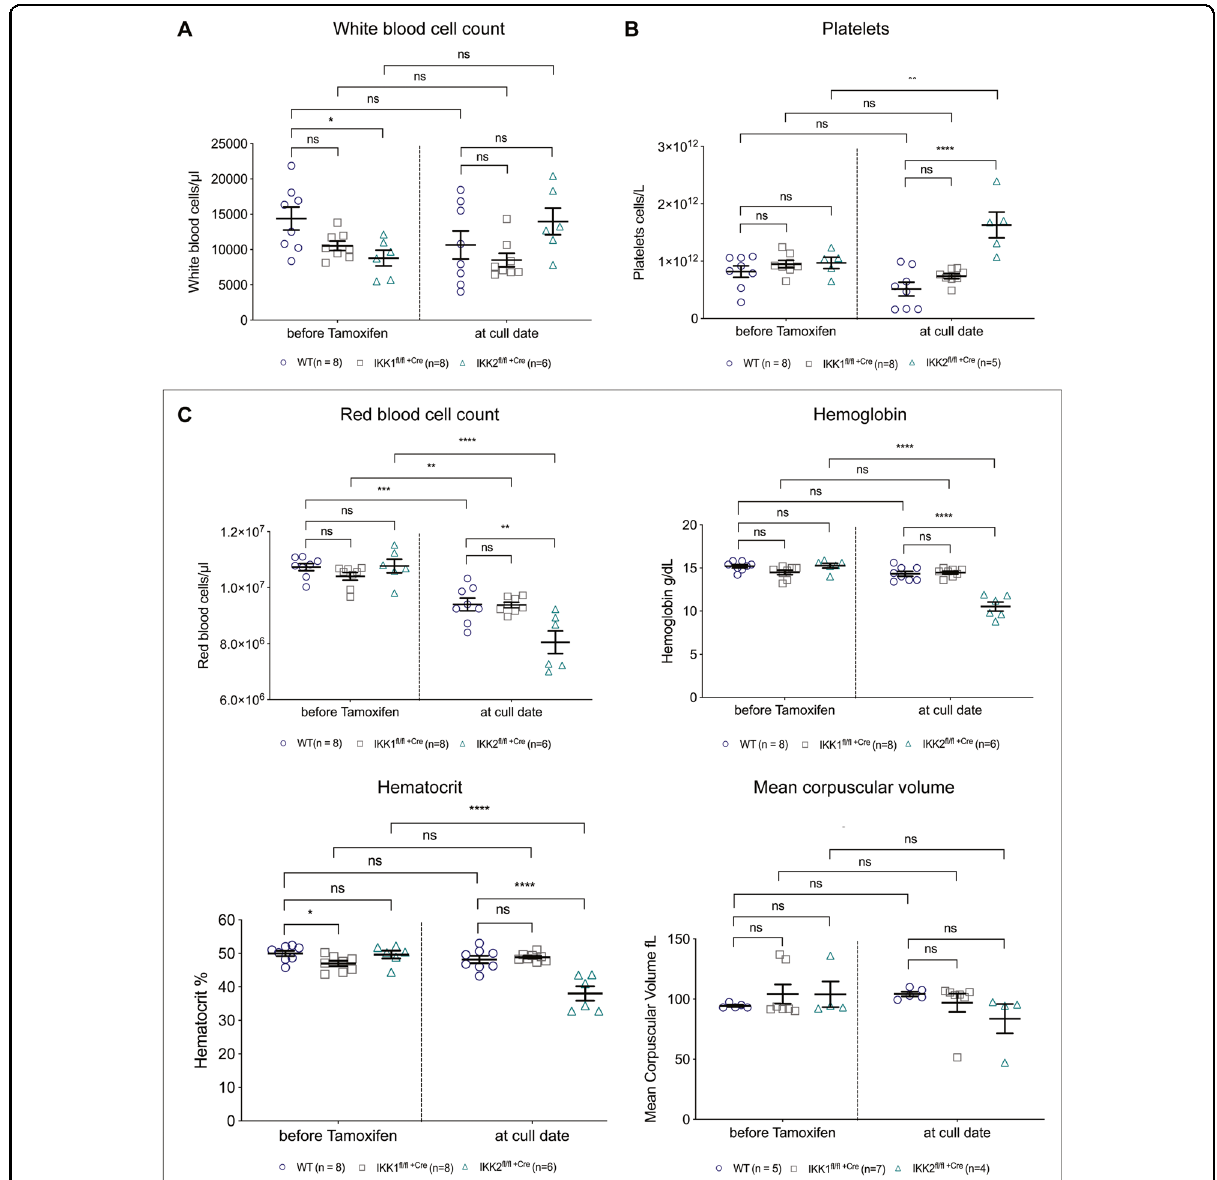
Fig. 2 IKK2 fl / fl + Cre mice have a normal white blood cell count but develop normocytic anaemia, presenting with signi fi cantly reduced red blood cell counts, lower haemoglobin levels and a decreased haematocrit, whereas the mean corpuscular volume (MCV) is in the normal range. IKK2 fl / fl + Cre mice further but present with thrombocytosis, evident by elevated platelet counts. A White blood cell count (WBC), B platelet count (PLT) and C red blood cell parameters, including total red blood cell count (RBC), haemoglobin concentration (HGB), haematocrit (HCT) and mean corpuscular volume (MCV), as assessed on the Avida 2120 haematological analyser. Individual values, mean and SEM are shown of two independent experiments. ns p > 0.05, ** p ≤ 0.01 and **** p ≤ 0.0001 as determined by one-way ANOVA (WT Cre + at sacri fi ce vs. IKK2 fl / fl Cre + at sacri fi ce: WBC p = 0.1024; PLT p < 0.0001; RBC p = 0.0019; HGB p = <0.0001; HCT p < 0.0001; MCV p = 0.2707) and Dunnett ’ s multiple comparison